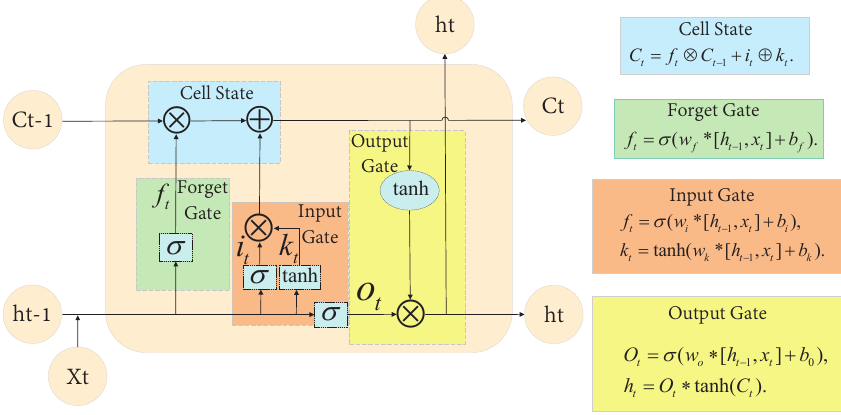
Figure 15. The basic framework of